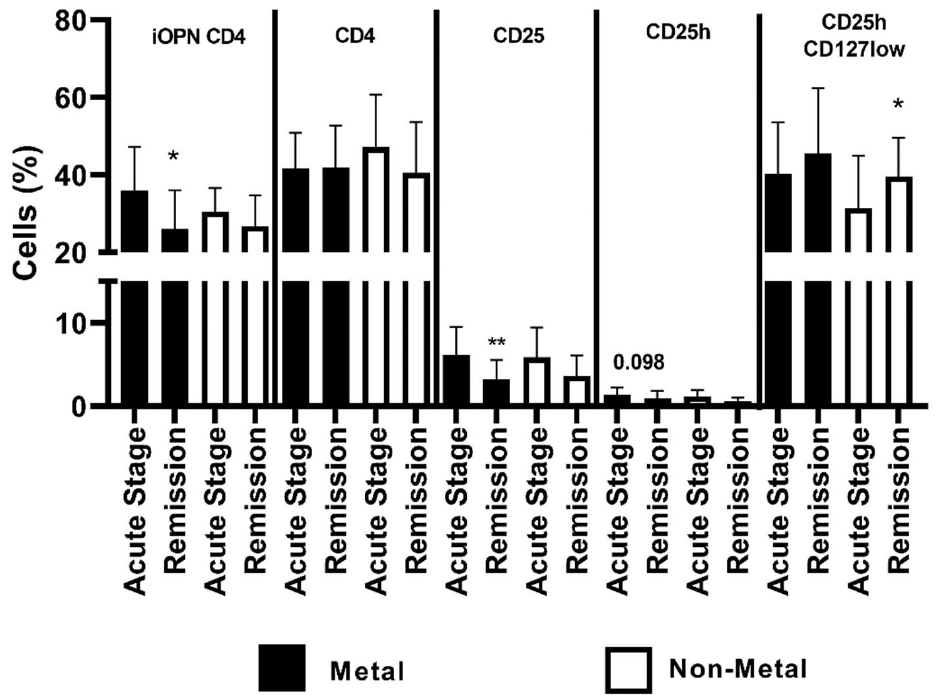
Figure 5. The percentage of examined populations of CD4 T lymphocytes depending on the type of allergen. iOPN CD4, CD4 T lymphocytes with expression of intracellular osteopontin; CD4, CD4 positive T lymphocytes; CD25, subset of CD4 positive T lymphocytes; CD25h, CD25 high T lymphocytes; CD25hCD127low, CD25highCD127low T cells—regulatory T cells; *, means statistical significance higher the percentage of iOPN CD4 with p values < 0.05 between patients in acute stage of ACD than in remission; **, means statistical significance higher the percentage of CD25 with p < 0.01 between patients in acute stage of ACD than in remission; *, means statistical significance higher the percentage of CD25hCD127low with p values < 0.05 between patients in remission of ACD than in acute stage. Table 5. ( A ) Comparison of selected variables in ACD patients depending on allergen. ( B ) Corre- lations of the percentage of iOPN CD4 lymphocytes with selected variables in the ACD patients depending on allergen. Data are presented as R values and followed with p values when p < 0.2. ( A